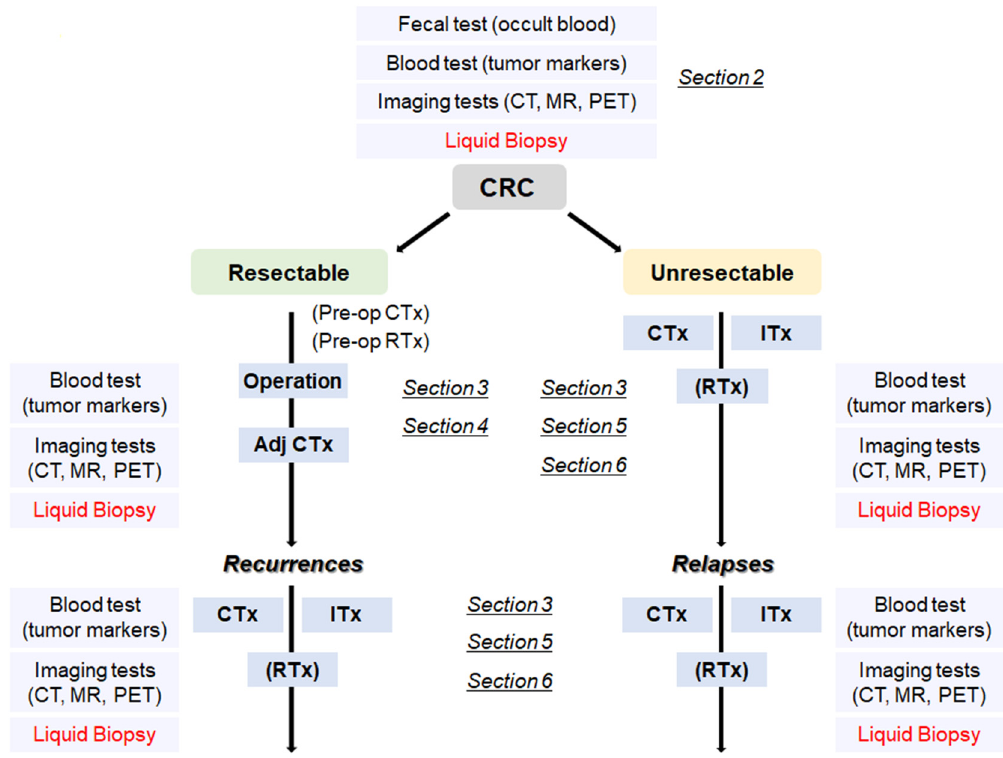
Figure 1. A flowchart from the diagnosis of CRC to treatment according to the disease progression. CRC: colorectal cancer, Adj CTx: adjuvant chemotherapy, CTx: chemotherapy, RTx: radiotherapy, Itx: immunotherapy.